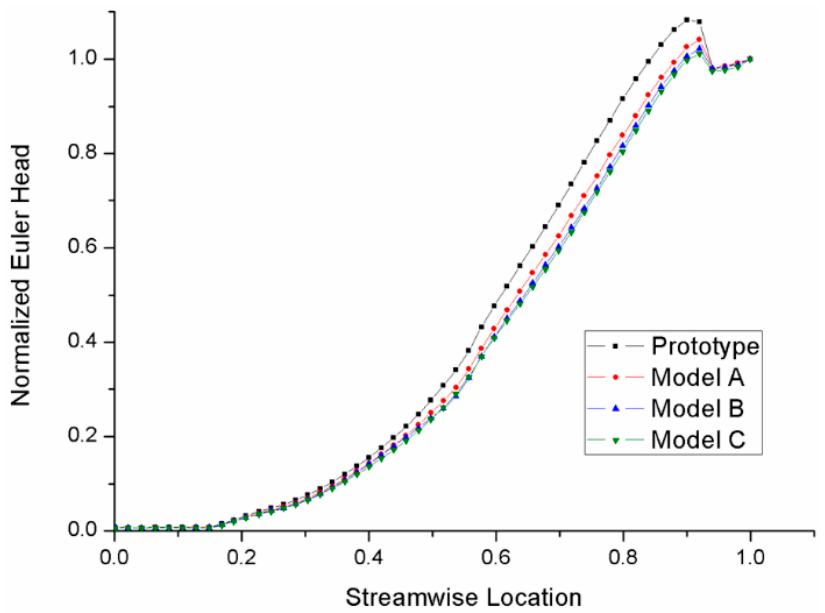
Figure 10. Normalized Euler head distribution in the streamwise location (span =